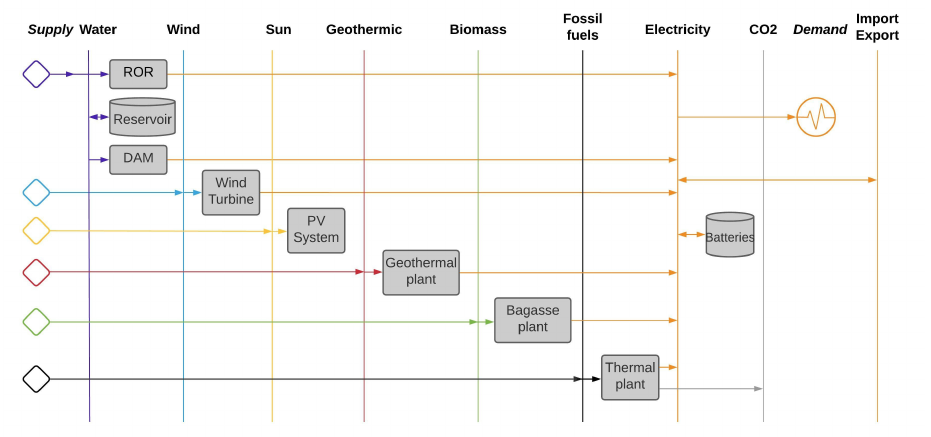
Figure 3. Ecuadorian power system representation in urbs